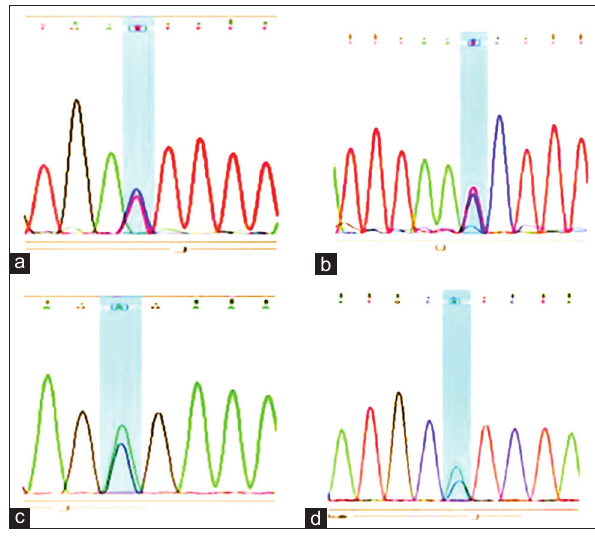
Figure-2: Representatives of the four detected single- nucleotide polymorphisms in heterozygous samples (a = nt. 111, b = nt. 143, c = nt. 211, d = nt.